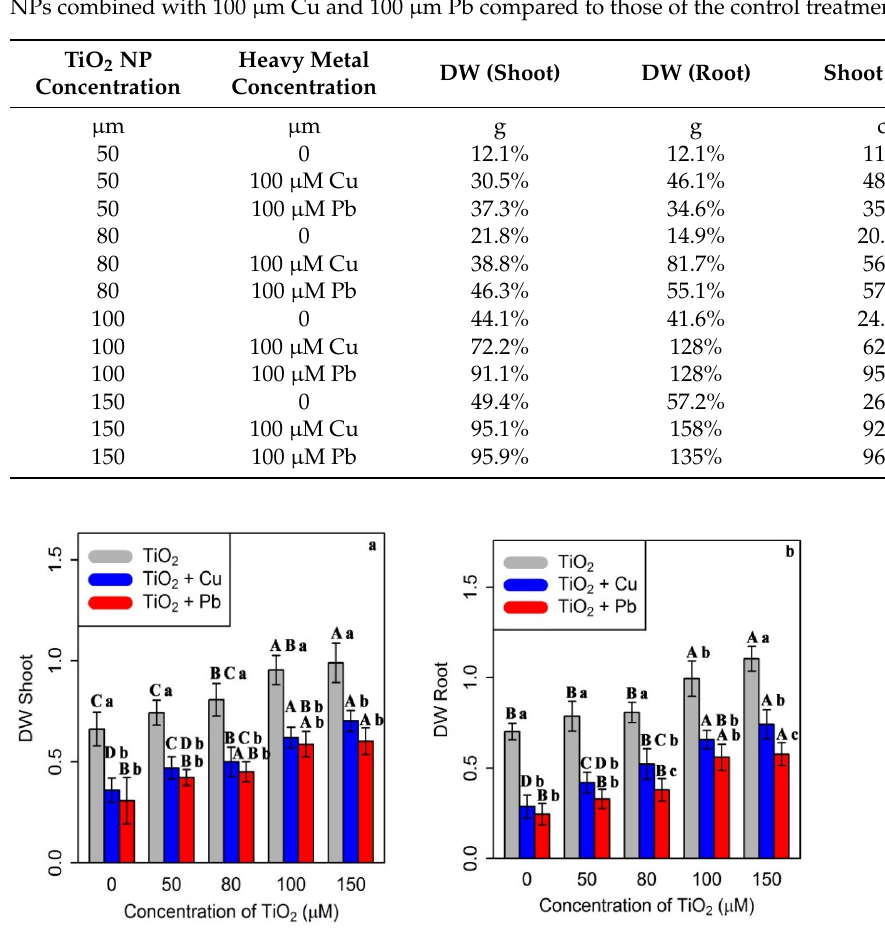
Figure 3. Impact of the combination of TiO 2 NPs with 100 µm Cu and 100 µm Pb on shoot dry weight (DW) ( a ), root dry weight (DW) ( b ) and shoot length ( c ) in A. pygmaea . Each data point is the mean ± SE of five replicates. The treatments contained various levels of TiO 2 NPs alone or in combination with 100 µM Cu and 100 µM Pb. The capital letters show statistically significant dif- ferences across various levels of TiO 2 NPs alone or in combination with 100 µM Cu and 100 µM Pb (the bars with the same colors), while the lowercase letters show statistically significant differences